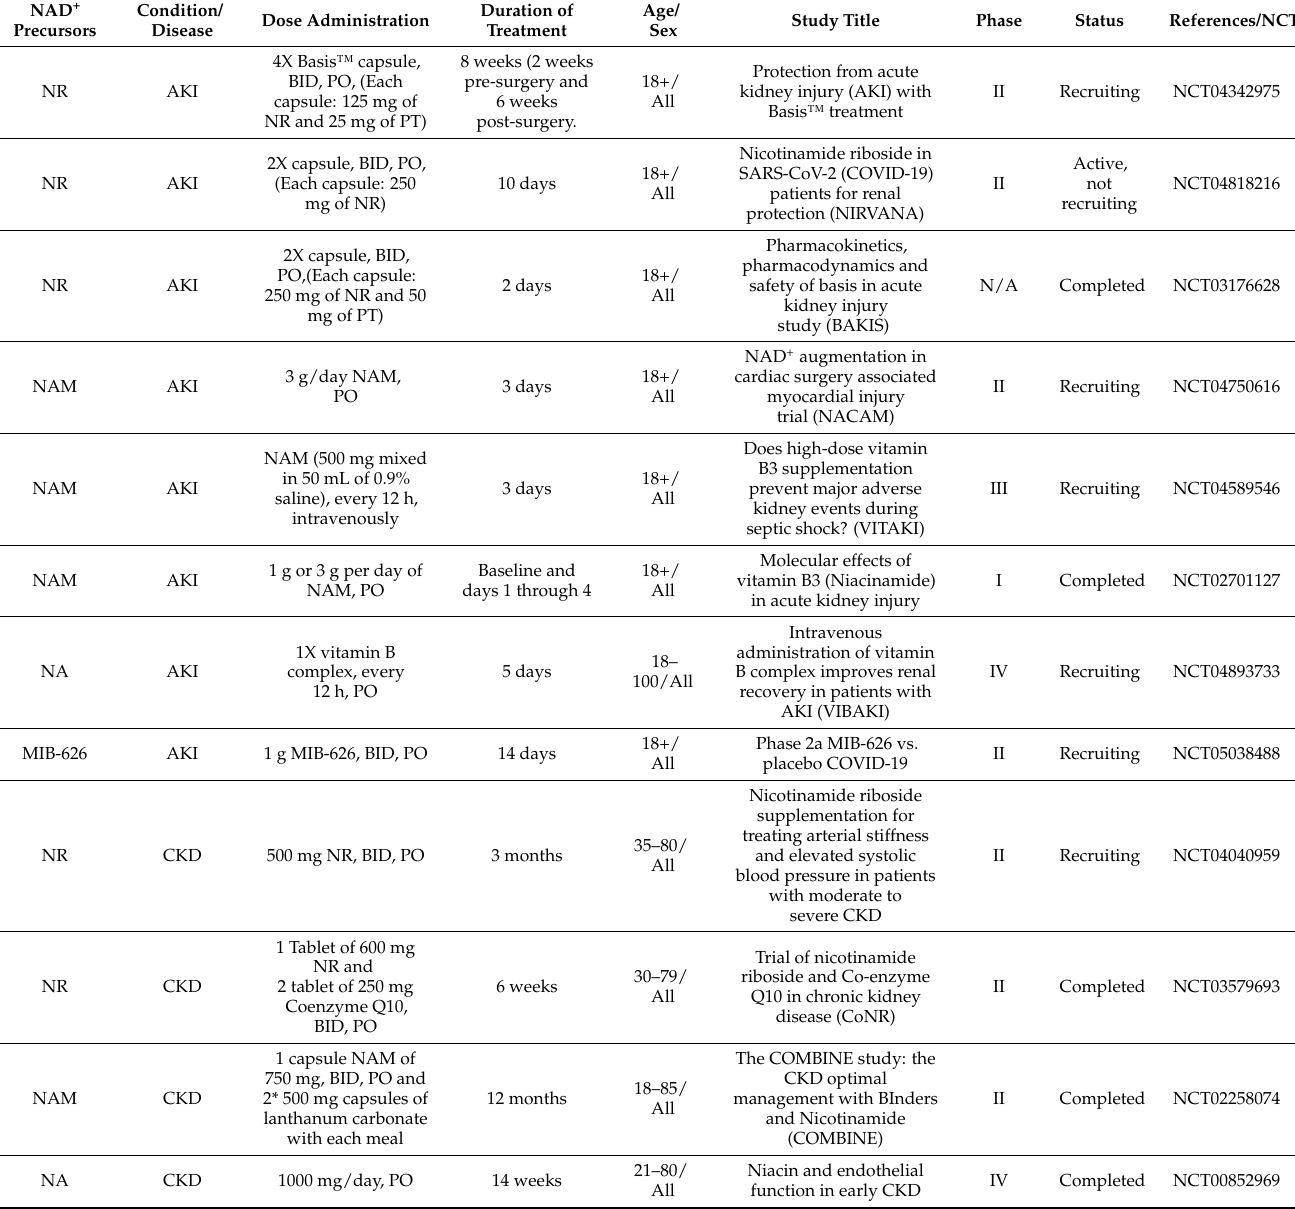
Table 2. A partial summary of human clinical trials of NAD + precursors in relation to AKI and CKD (clinicaltrials.gov accessed on 2 December